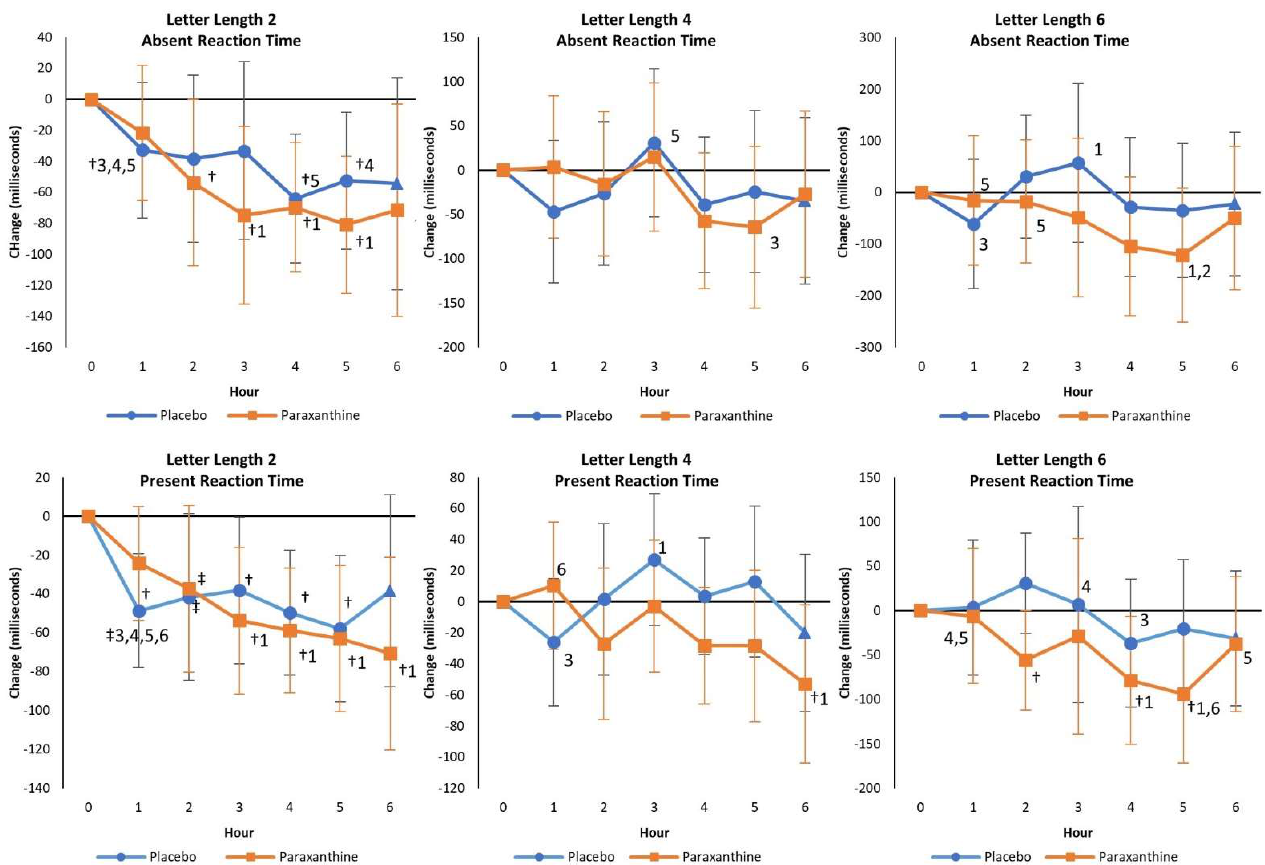
Figure 5. Mean changes with 95% confidence intervals in absent and present reaction times. † represents p < 0.05 change from baseline values. ‡ represents p > 0.05 to p < 0.10 change from baseline values. Numbers 1, 2, 3, 4, 5, and 6 represent p < 0.05 differences from the hour values shown.